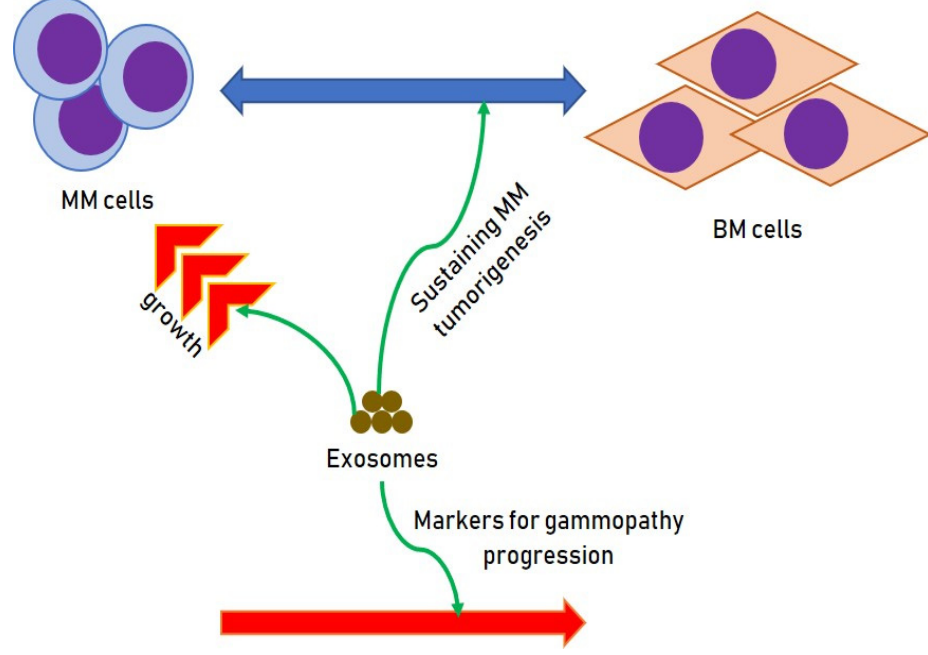
Figure 1. Effects of exosomes on MM cells.